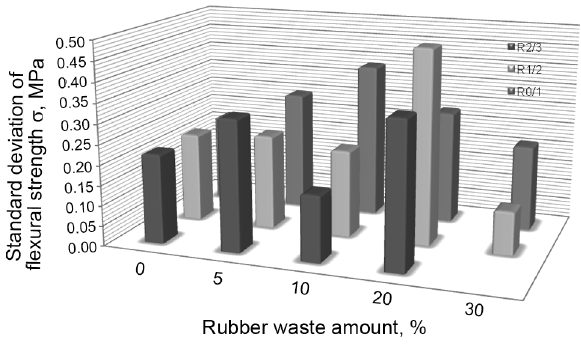
Fig. 6. Standard deviation of the flexural strength of concrete